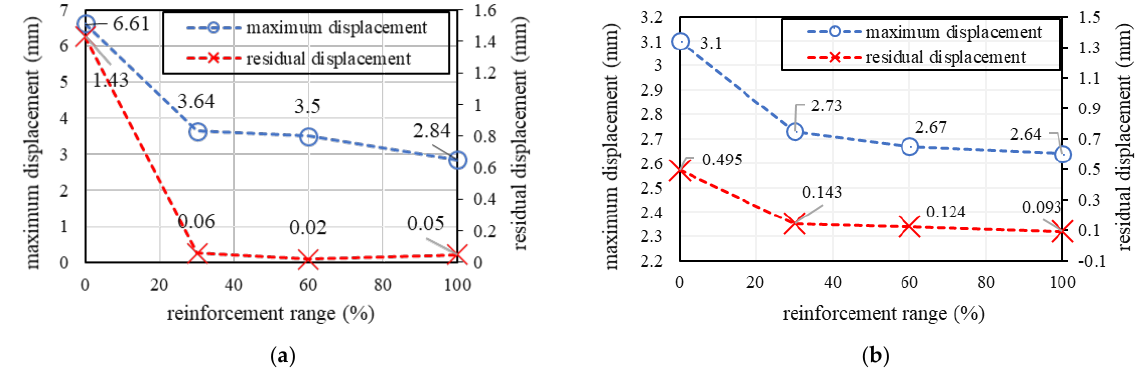
Figure 29. Comparison of maximum displacement and residual displacement of TYPE-A: ( a ) wave A; ( b ) wave B.